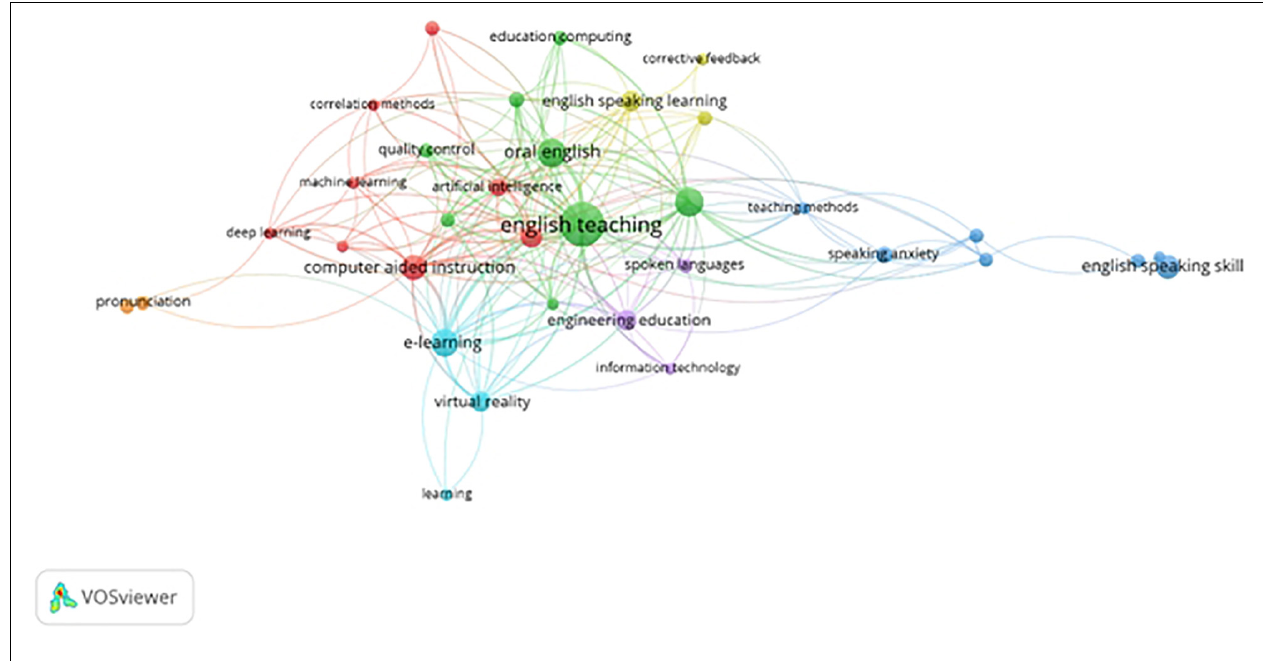
FIGURE 7 | The network visualization map of co-occurrence of keywords.